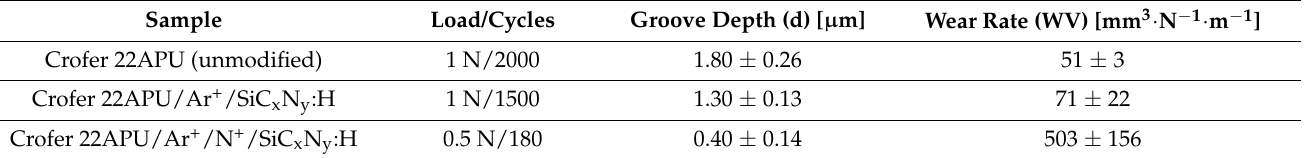
Table 5. Wear rate and grove depth of unmodified Crofer 22APU steel and after plasma modification.